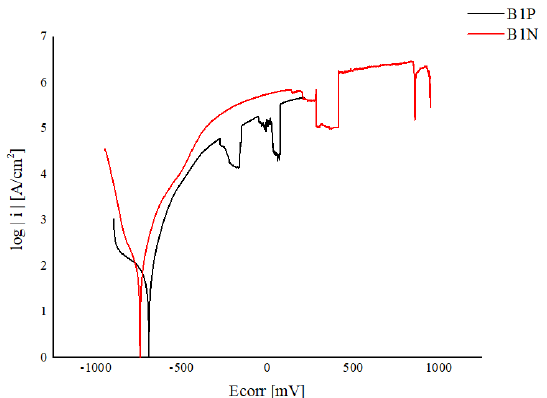
Figure 13. Polarization curves with the results of electrochemical tests for the B1P and B1N samples, where B1P is a post-operated state and B1N is a specimen after normalization.